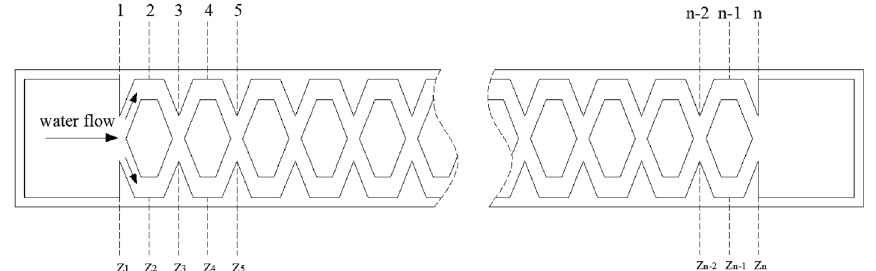
Figure 3. Schematic of water flow in pit flow